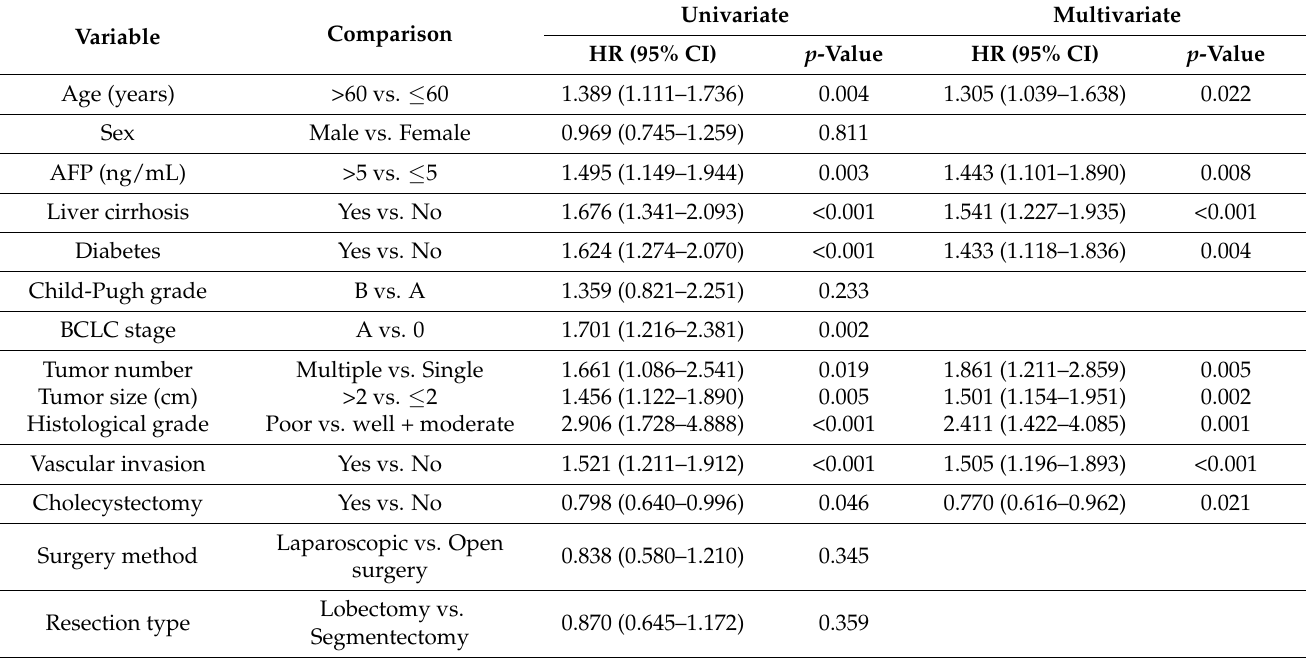
Table 2. Univariate and multivariate analysis of recurrence for propensity score-matched patients with BCLC 0/A stage